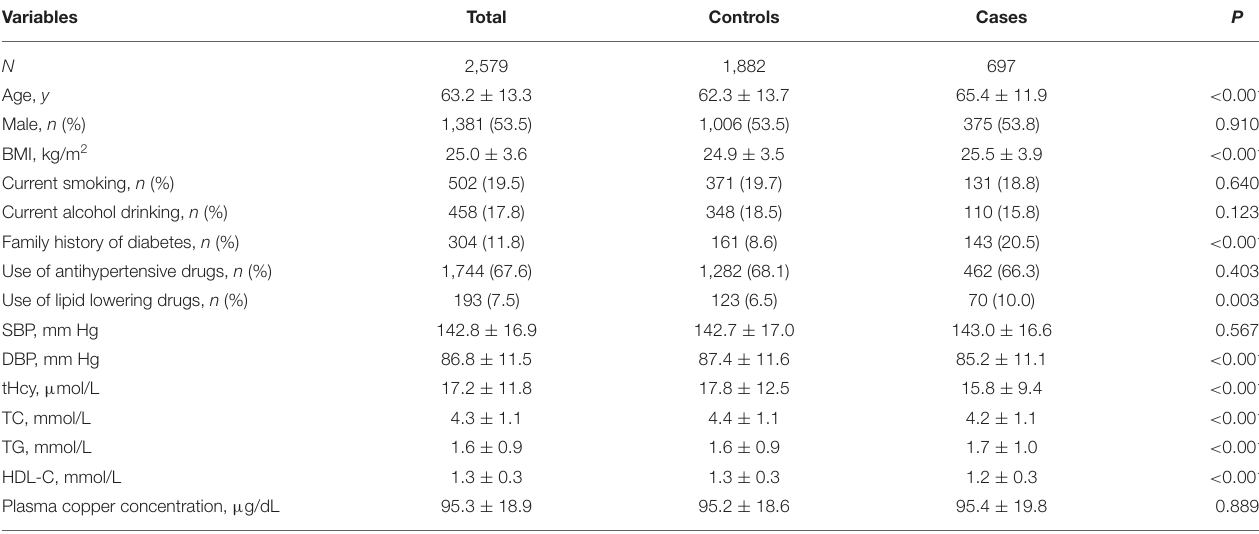
TABLE 1 | Characteristics of 2,579 Chinese adults with hypertension by diabetic status a . Variables Total